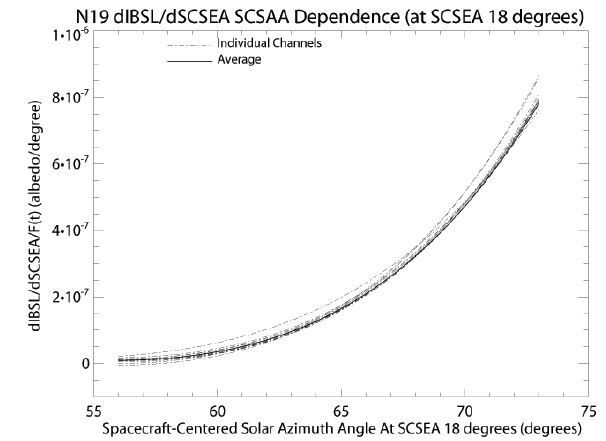
Fig. 12. Fitted S (SCSAA) functions for the IBSL slope, dIBSL/dSCSEA, at different wavelengths can be approximated with an average (solid